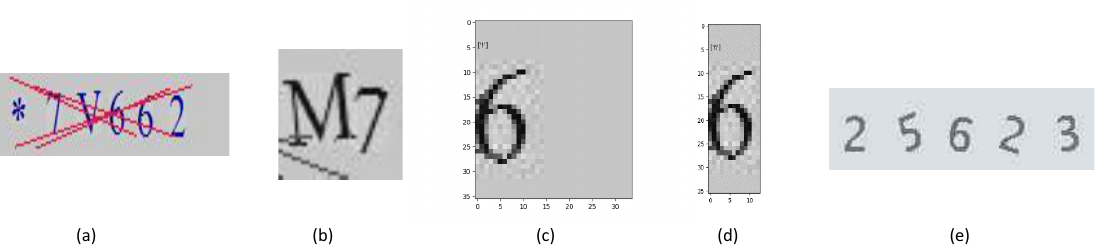
Figure 11. Examples of External Benchmarks. ( a ) An example of external benchmark HaskKiller13. ( b ) TOD failed to segment the two characters. ( c ) Result after TOD segmentation. ( d ) Result after the combined method. ( e ) An example of external benchmark Delta40.